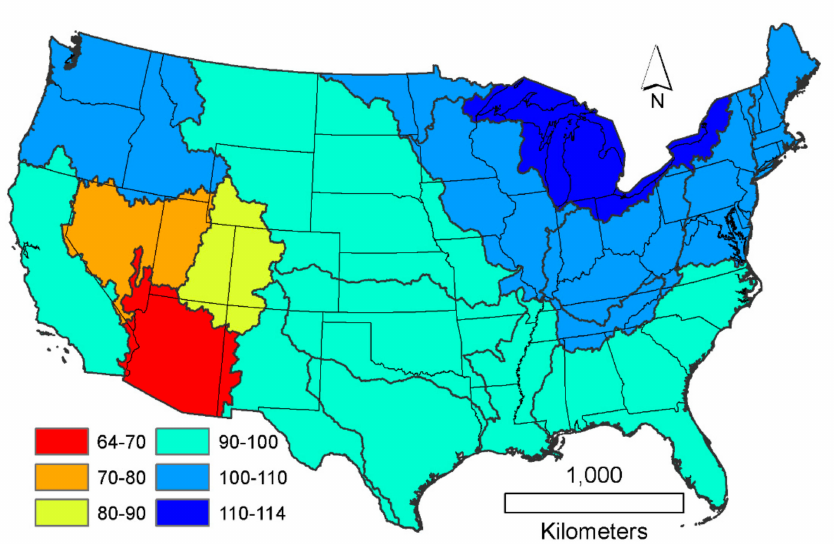
Figure 8. Spatial distribution of the relative errors (%) in the long-term (1979–2015) mean annual HUC2 precipitation